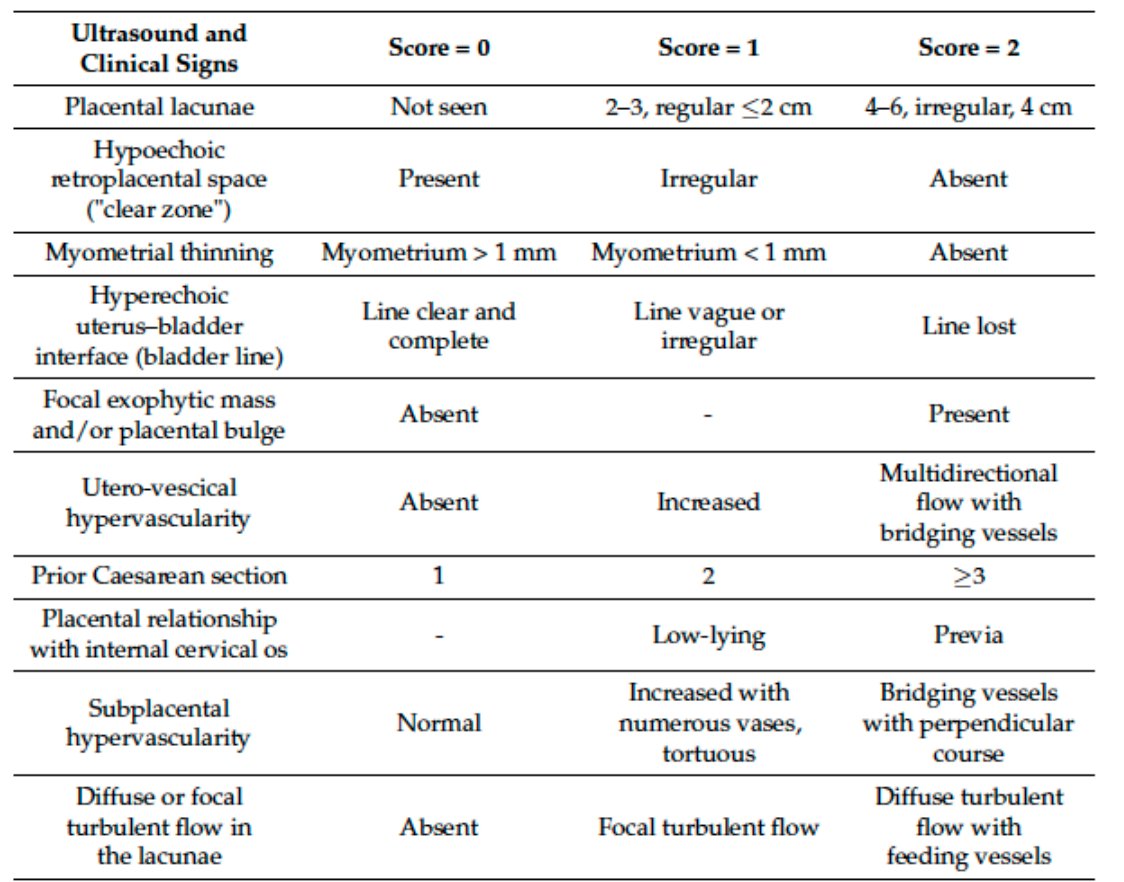
Figure 1. US score for PAS diagnosis.